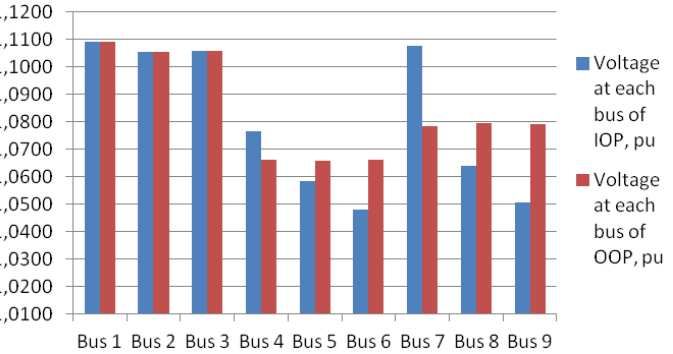
Figure 6. Voltage improvement at each bus.